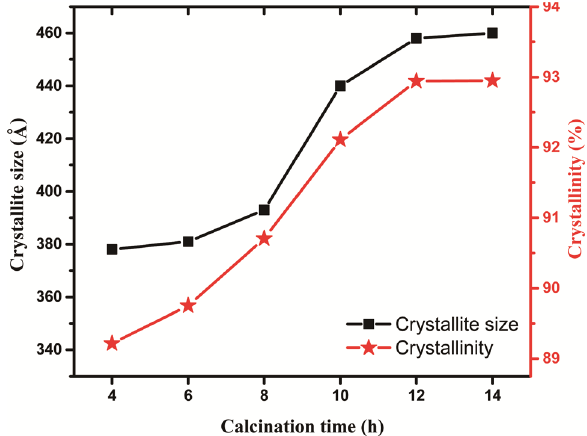
Fig. 7 Effect of calcination time on the crystallinity and crystallite size of Ca 3 Co 4 O 9